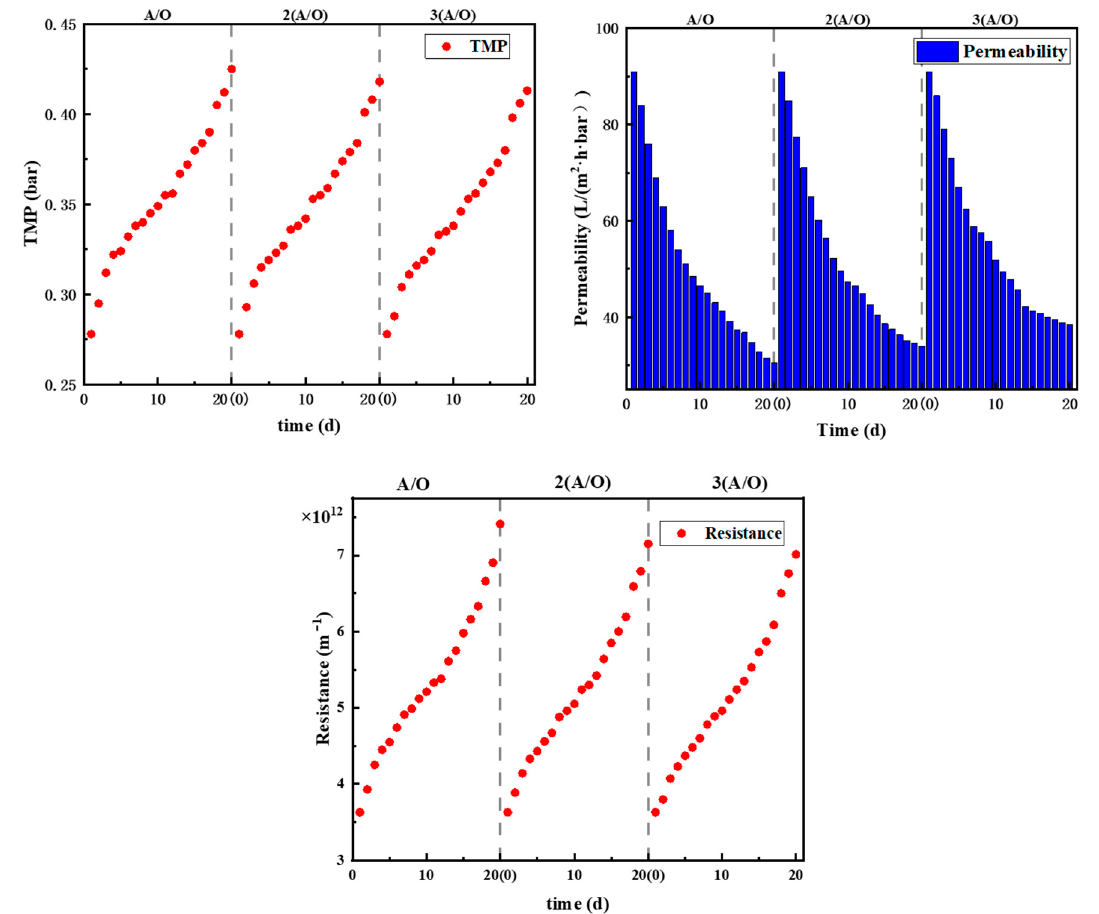
Figure 4. Changes of TMP, permeability and overall resistance with time in each process. The membrane is chemically cleaned with NaClO after each test. The TMP of the three membrane modules after cleaning drops to 0.301 bar, 0.296 bar and 0.290 bar.